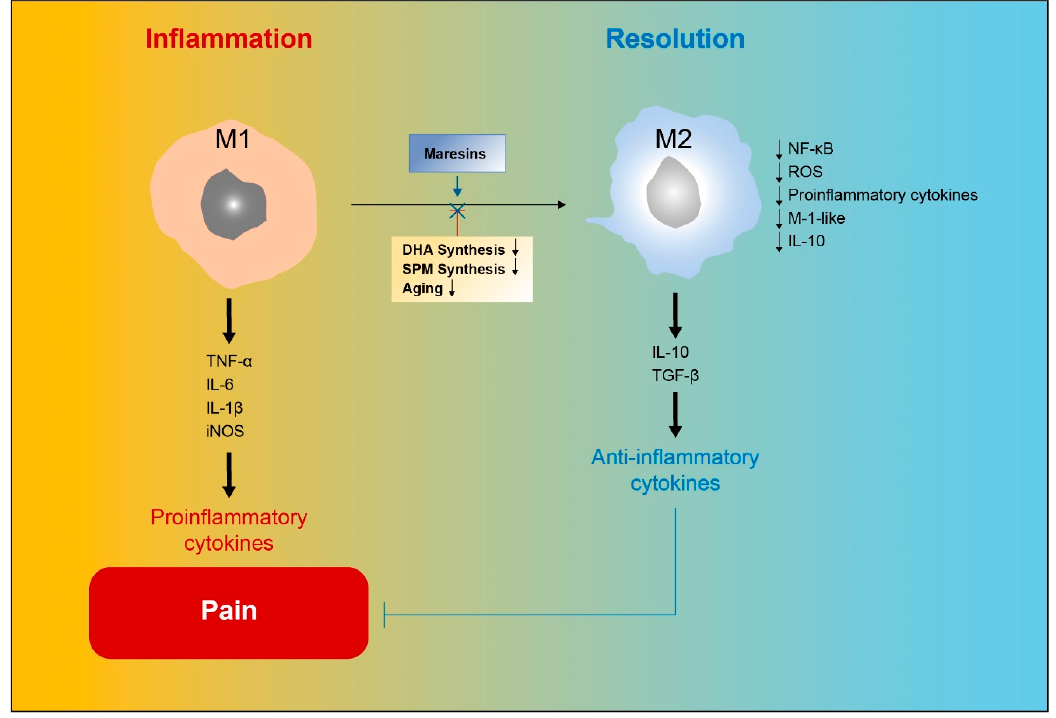
Figure 4. Maresins regulate macrophage phenotype and resolution of inflammatory pain. Maresins (MaRs) improve M2 macrophage function, shifting cytokine release to an anti-inflammatory profile and thereby facilitating the resolution of inflammatory pain.